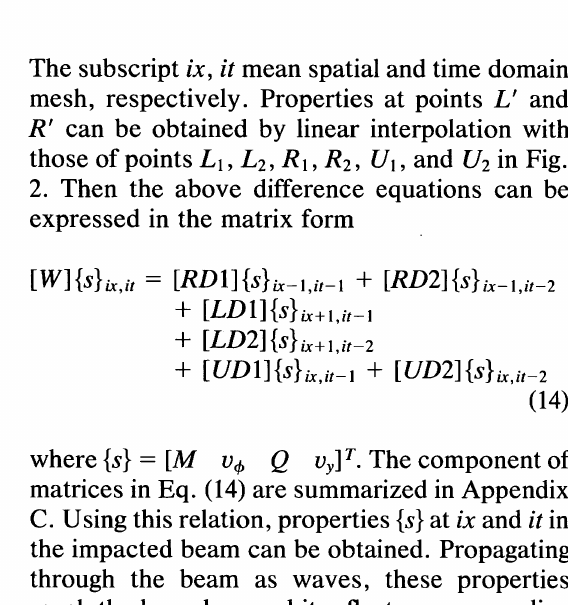
FIGURE 2 Formation of properties {s} at point P.